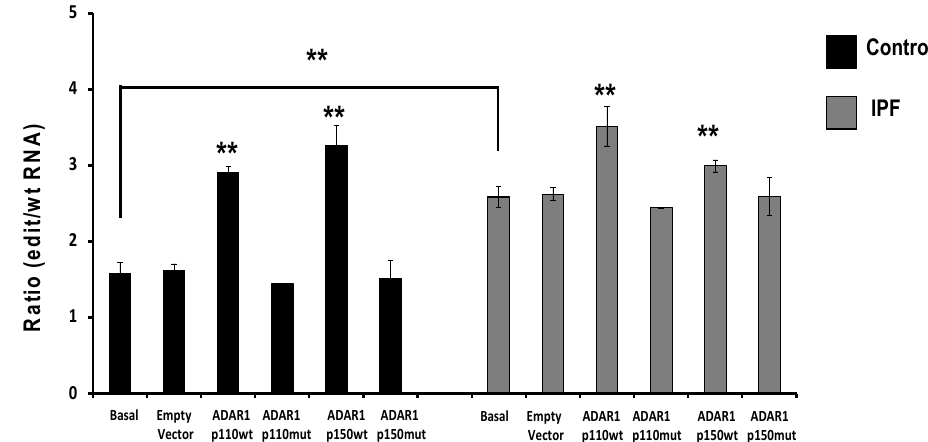
Figure 3. The catalytic activity of ADAR1 on APOBEC3D in control fibroblasts compared with fibrotic fibroblasts. ADAR1 catalytic activity in basal conditions in IPF fibroblasts concerning control fibroblasts (** p = 0.0018). Editing activity increase is shown as the ratio of the edition divided by the ratio of wild-type ( n = 6). The catalytic activity is increased after transfection with the catalytically active plasmids, whereas the mutant plasmids do not modify the activity. In control fibroblasts (black bars), ADAR1 p110 wt shows a significant increase in editing activity (** p = 0.003737). Remarkable increase in editing activity is observed with the ADAR1-p150 isoform (** p = 0.000139), while the greatest increase the editing activity in IPF fibroblasts are observed after over-expression of the ADAR1-p110 (** p = 0.007030). An increase in ADAR1-p150 wt activity was also significant (** p = 0.009158).